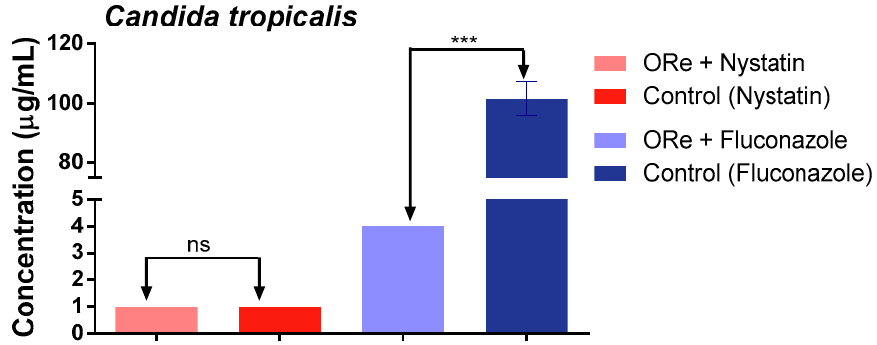
Figure 3. Minimum inhibitory concentration of nystatin and fluconazole in the presence and absence of R. echinus leaf essential oil for Candida tropicalis . ORe = R. echinus leaf essential oil. Statistical analysis: one-way ANOVA followed by Bonferroni post-hoc test. *** p < 0.001 indicates significant difference when R. echinus leaf essential oil was added to the medium. ns, not significant. Data show mean + SEM from three independent experiments performed in triplicate.